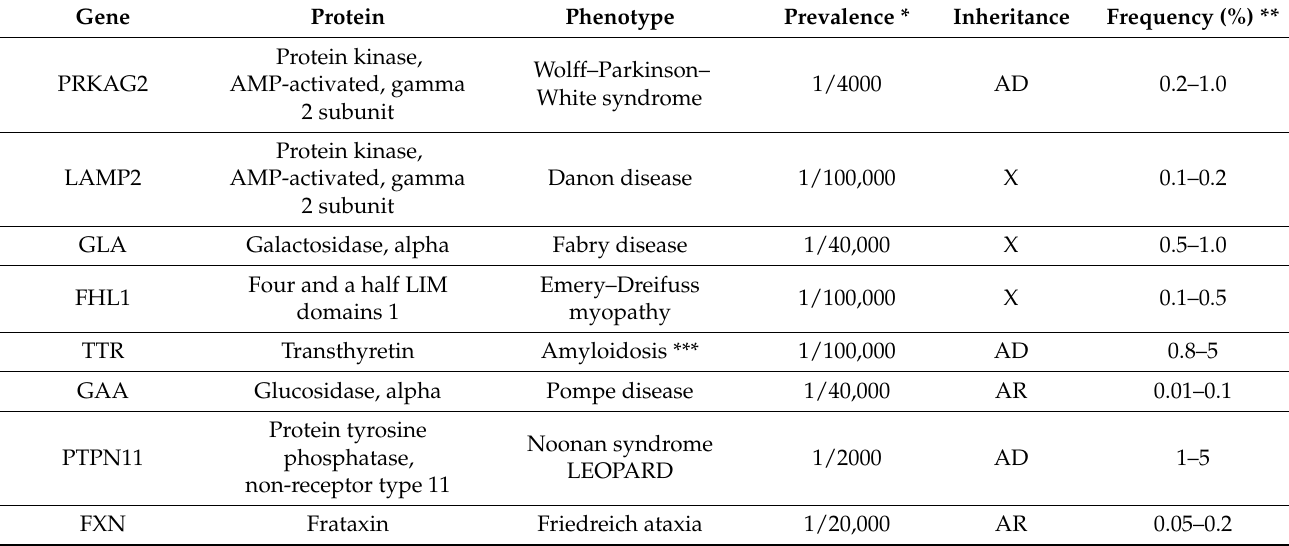
Table 2. Non-sarcomeric genes associated with